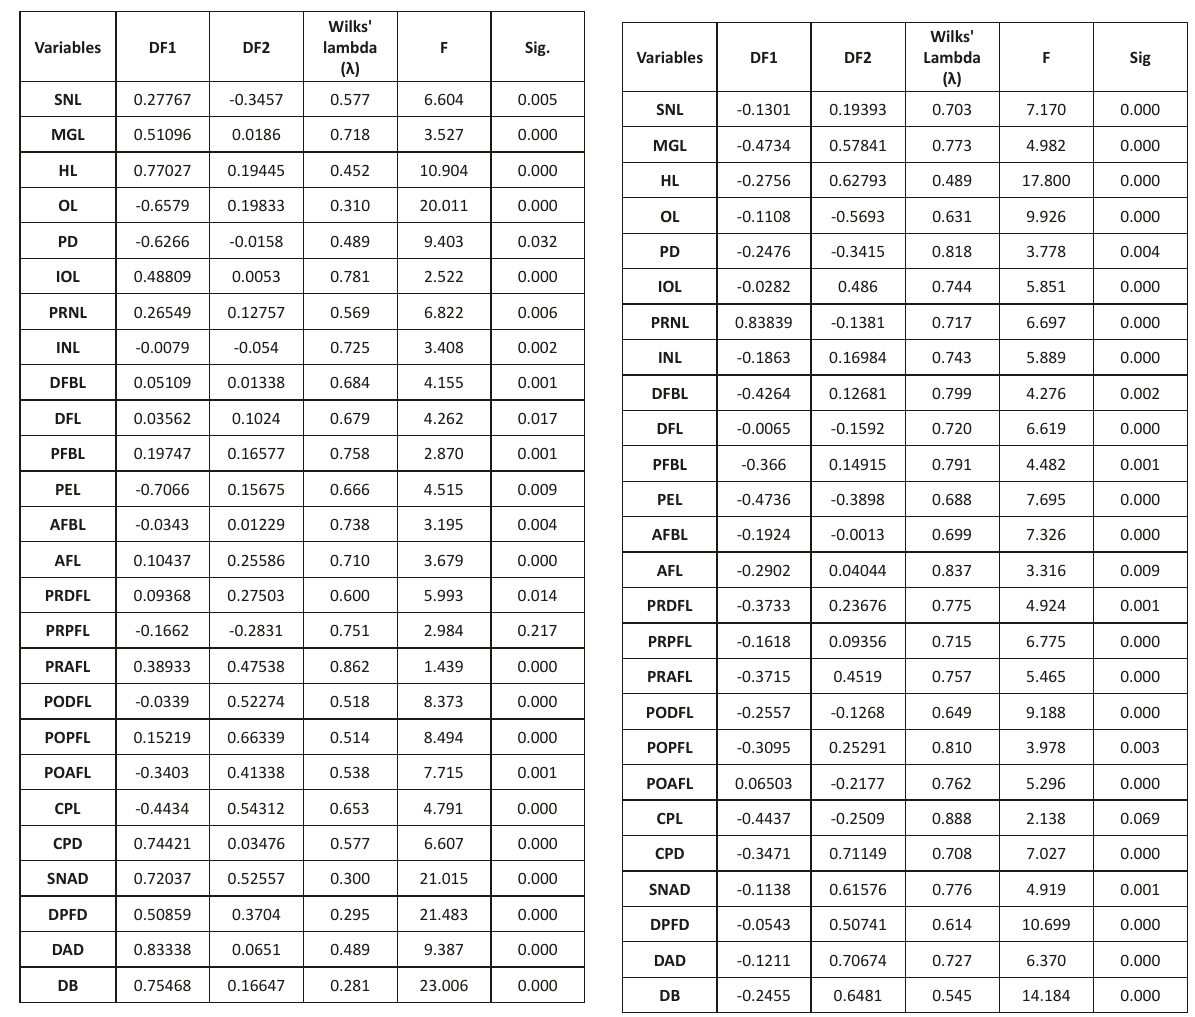
Table 4. Discriminant function analysis for Arothron & Lagocephalus — loading scores on the discriminant functions DF1 & DF2 and discriminatory power of morphometric characters Wilks’ lambda (λ), F value & significance.